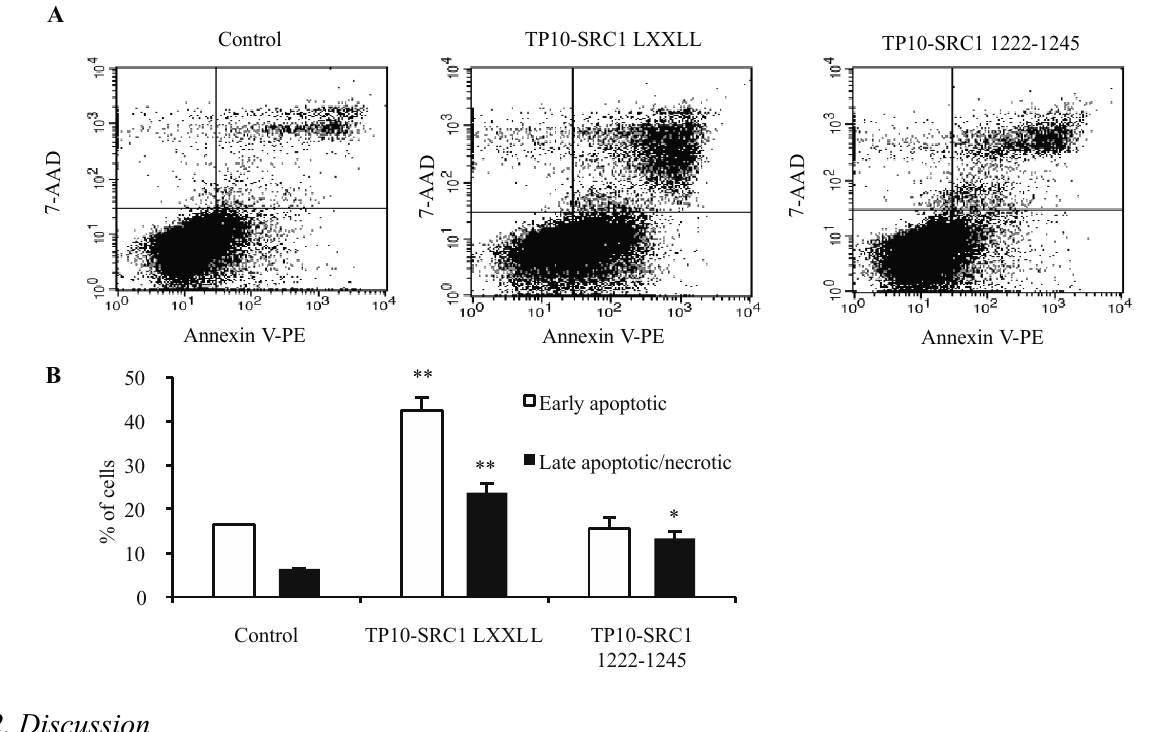
Figure 4. Flow cytometric detection of apoptosis by annexin V and 7-amino-actinomycin D (7-AAD) staining. ( A ) Representative dot plots of 7-AAD versus annexin-V-PE. MCF-7 cells were left untreated (control) or were treated with 5 µM of peptide for 24 h in media supplemented with 1% serum. The lower left quadrant contains the vital (double negative) population; the lower right contains the apoptotic (annexin V + /7-AAD − ) population; the upper right contains the late apoptotic/necrotic (annexin V + /7-AAD + ) population; and the upper left contains the pre-necrotic (annexin V − /7-AAD + ) population; ( B ) Average percentage of apoptotic and late apoptotic/necrotic cells counted from dot plots taken from one representative experiment, error bars indicate mean ± SD. Data are statistically significant with * p < 0.05, ** p < 0.01. In total, three independent experiments were performed. 7-AAD, 7-amino-actinomycin D; PE, phycoerythrin; TP10-SRC1 sequence of SRC1 NR box 1 with N -terminal TP10; TP10-SRC1 randomly chosen non-structured fragment of SRC1 with N -terminal